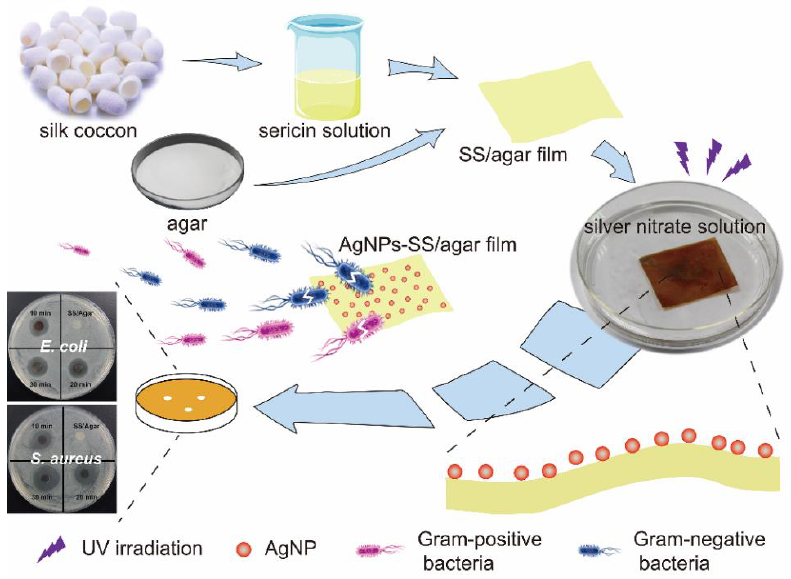
Figure 1. A diagram of the fabrication and antimicrobial test of the AgNPs/SS/agar film.